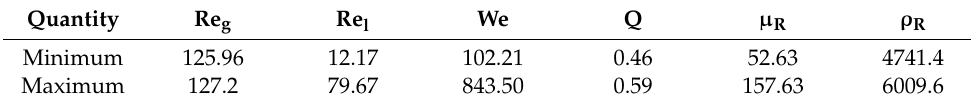
Table 1. The dimensionless number range used in the